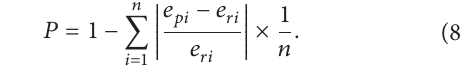
is 45.7 m. The average east error is 96.4 m, while the expected value of east error by prediction is 1194.6 m. The standard deviation of east error by prediction is 103.7 m.